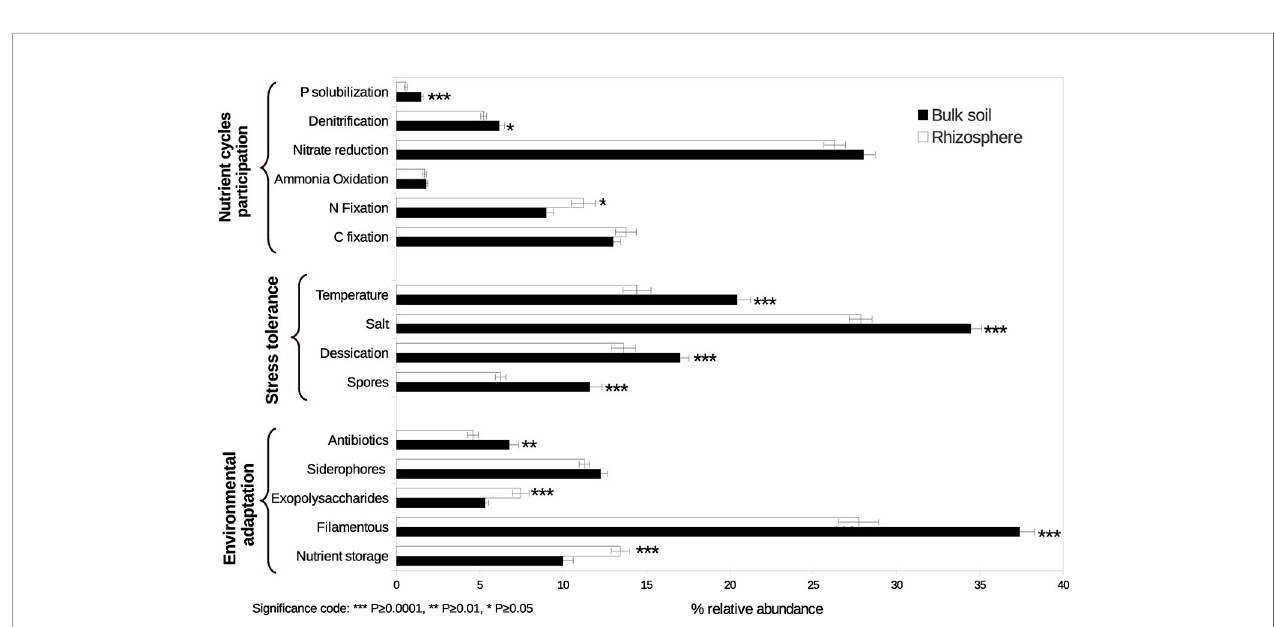
FIGURE 2 | Relative abundance of functional guilds participating in nutrient cycles, traits conferring stress tolerance, and traits conferring environmental adaptation in rhizosphere and bulk soil. Asterisks indicate signi fi cant differences. Bars represent standard errors.